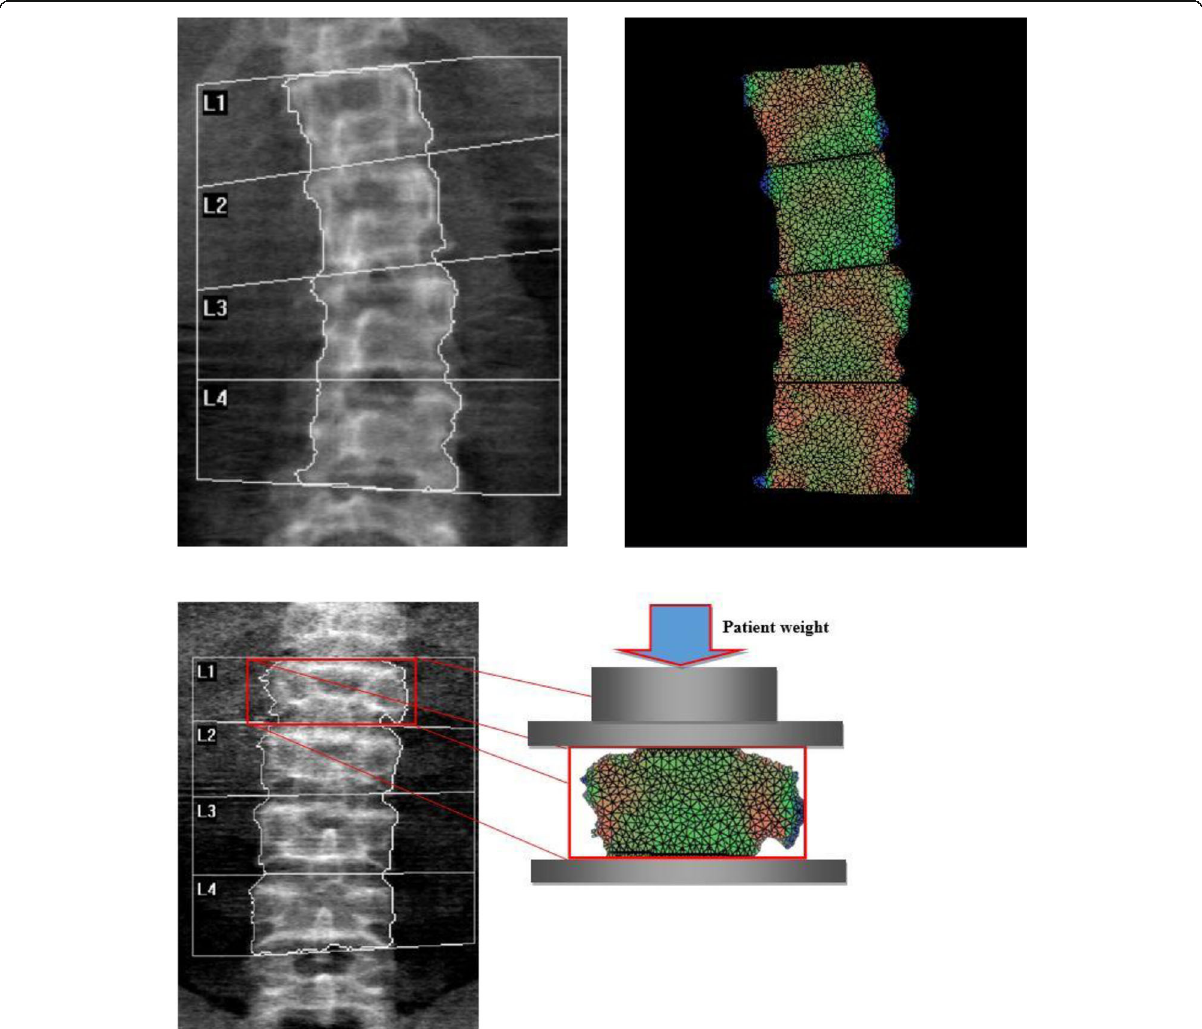
Fig. 1 Example of a lumbar dual-energy x-ray absorptiometry (DXA) scan in the absence of fracture (upper left) and its bone strain index distribution (upper right). Example of a spine DXA scan (bottom left) and of bone strain index distribution for a fractured lumbar vertebra (bottom right) after distribution